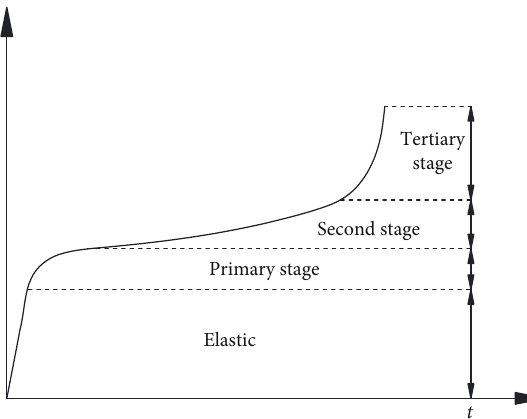
Figure 5: Creep deformation diagram.